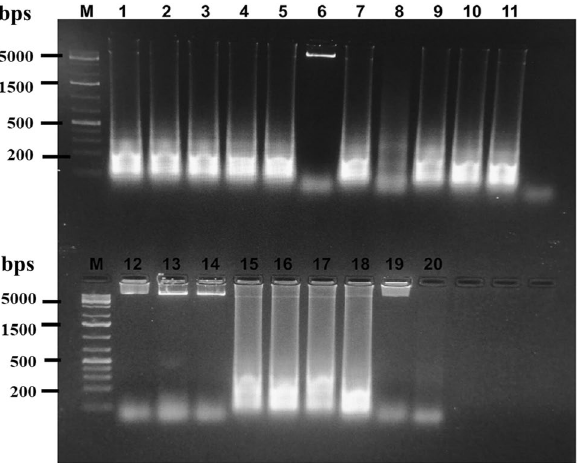
Figure 4. ML-specific LAMP technique in clinical samples. Lane 1: Positive control, Lanes 2–11 and 13–20: Clinical samples, Lanes 12 and 21: No template controls.